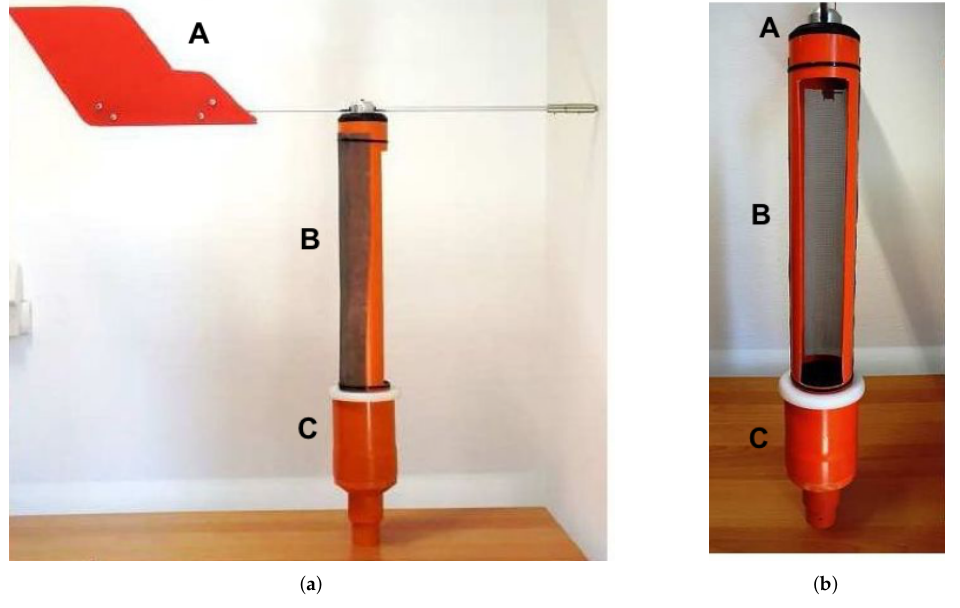
Figure 2. Prototype of the mechanical structure: ( a ) lateral view and ( b ) frontal view. Starting from the top of each subfigure: the weather vane (A), the rotating part with the front opening to let the sand enter (B), the fixed base that will be placed under the beach level